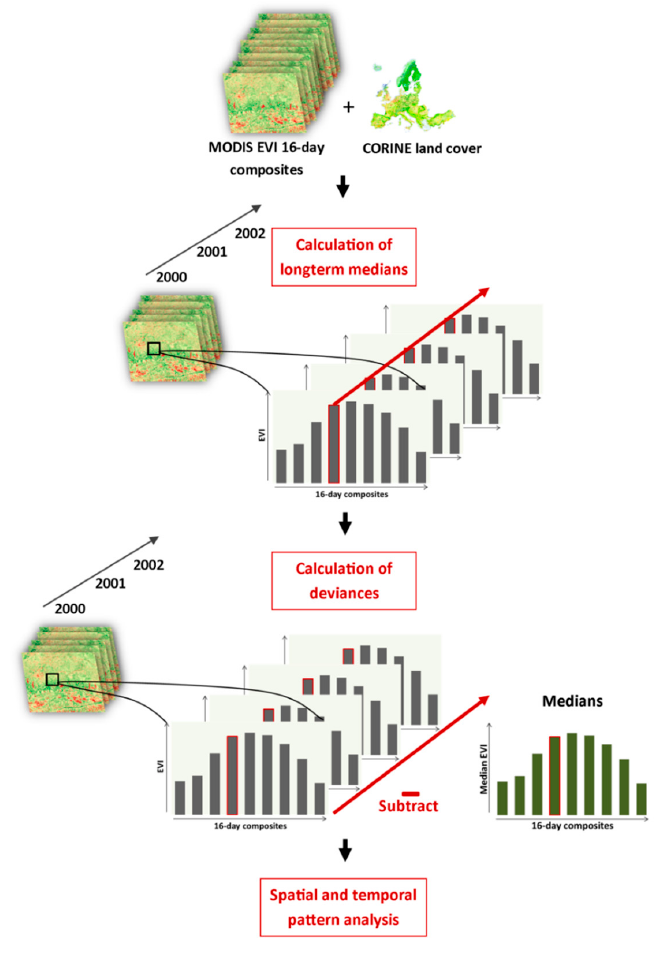
Figure 2. Schematic flowchart. Table 1. Indication of the respective two 16-day composites used to create each monthly anomaly. For leap years, the start dates are one day earlier from March onward. The 23rd of April is used for the April composite and for the May composite.